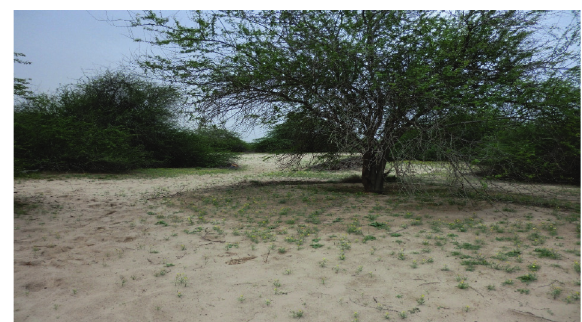
Figure 5: The effect of mesquite trees on the annual understory plants.